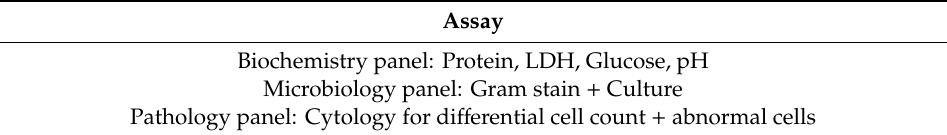
Table 2. Minimum standard assays for